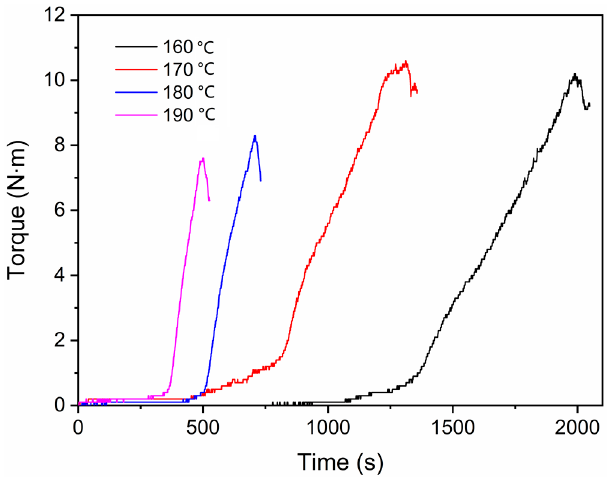
Figure 1. Development of torque over time for the dynamic crosslinking of diglycidyl ether of bisphenol A (DGEBA) with sebacic acid (SA) in the presence of Zn(acac) 2 , carried out at different temperatures.